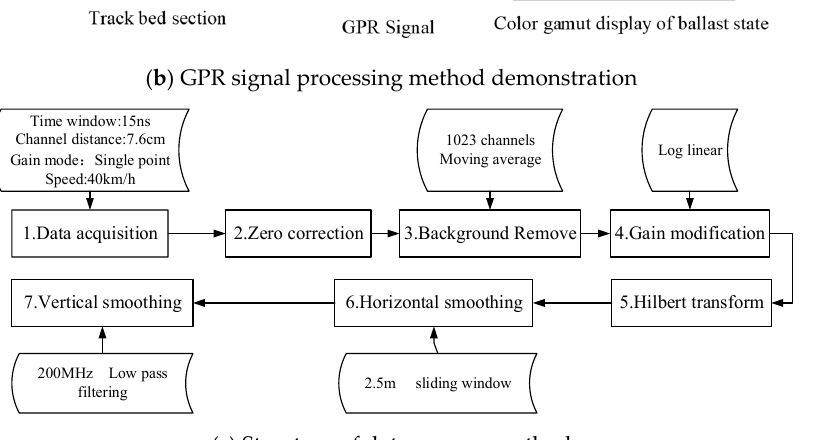
Figure 14. ( a – c ) demonstrate the GPR system and GPR signal processing method. US Federal Railroad Administration high-frequency GPR inspection (modified after [23]).